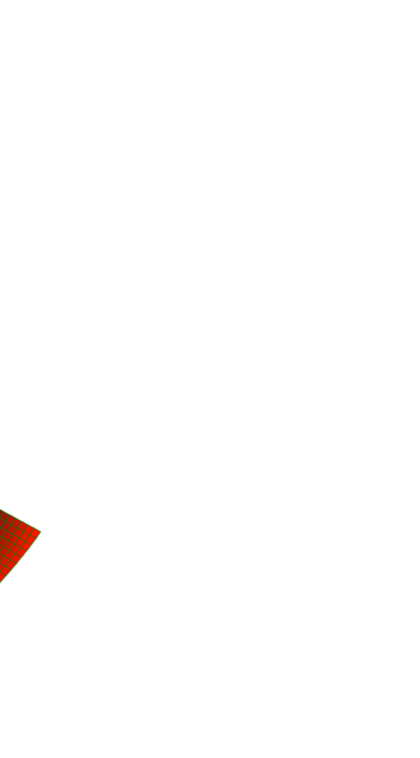
Figure 5. Stable shapes of a cross-ply (0/90) bistable composite, ( a ) the first stable ( b ) the second stable